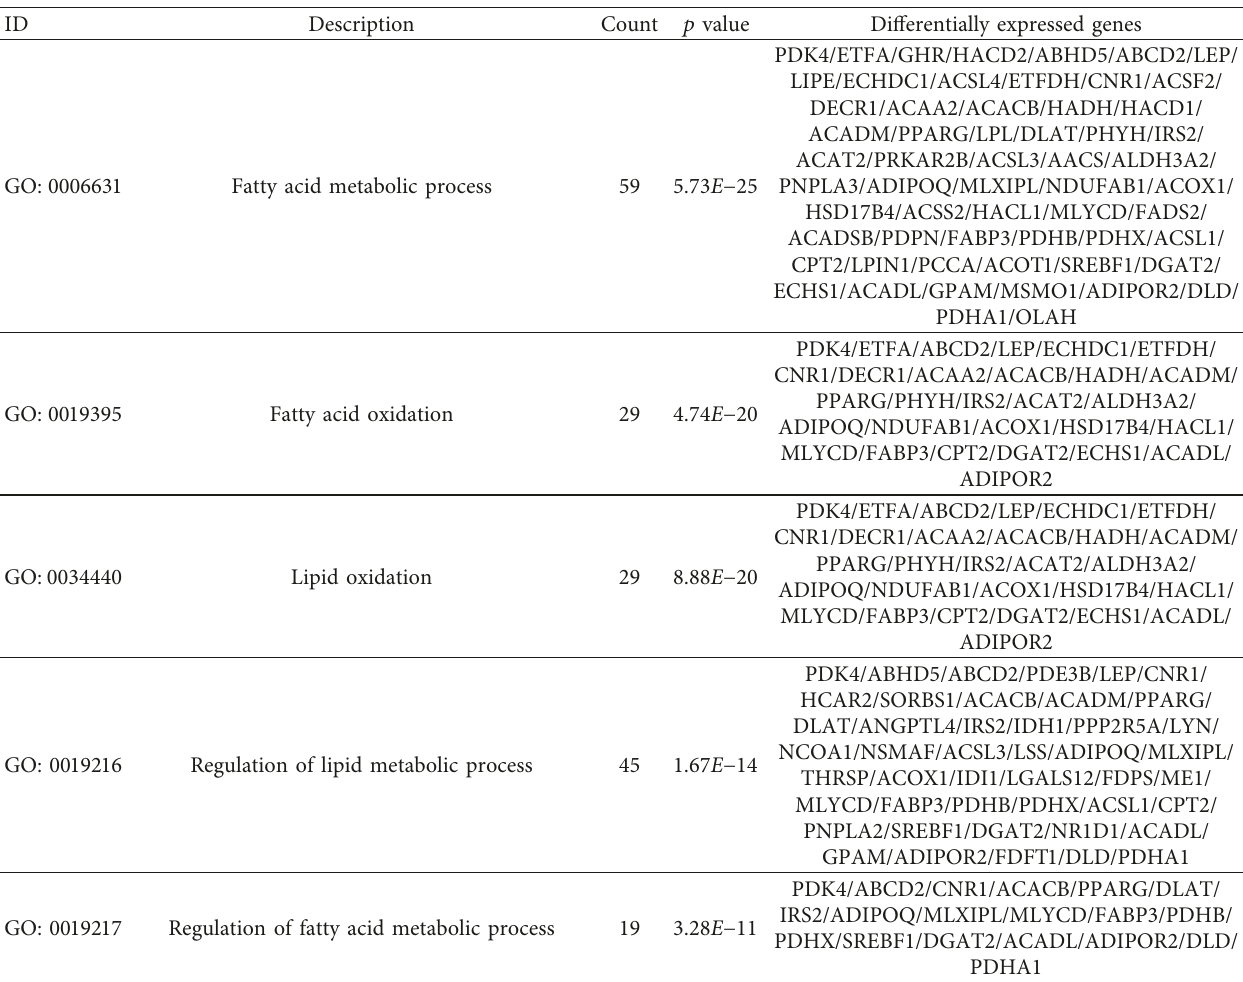
Table 2: GO biological processes enrichment analysis results (InG vs.